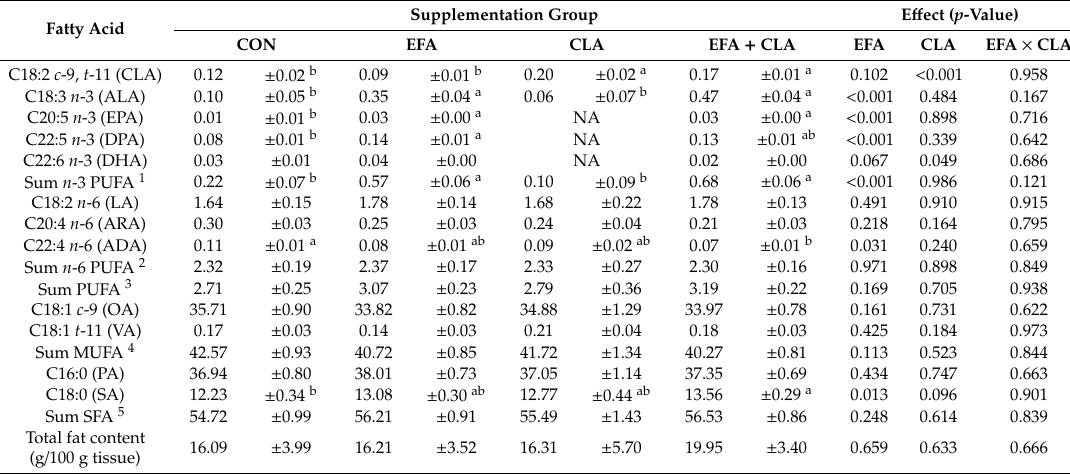
Table 2. Fatty acid composition (% of total fatty acids) of subcutaneous fat of calves of four maternal supplementation groups: Control group (CON, n = 8), essential fatty acids (EFA, n = 9), conjugated linoleic acids (CLA, n = 8), EFA + CLA (n = 10). Data are given as LSM ± SE LSM . Results for all measured fatty acids are listed in Supplementary Table